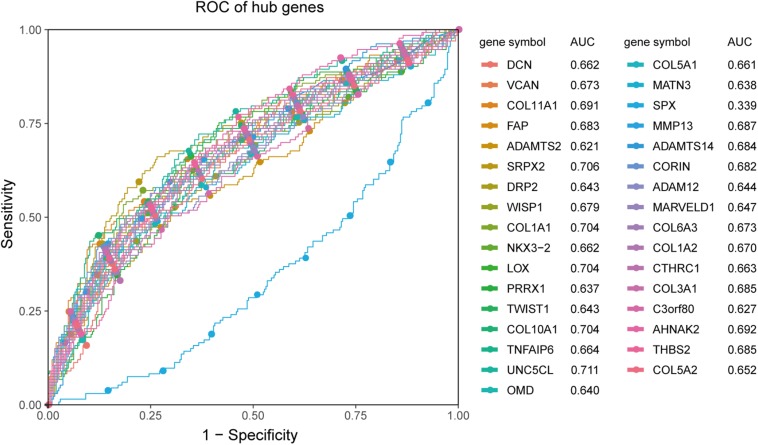
ROC analysis and AUC calculations for hub genes in the TCGA438 dataset. Genes with AUC values <0.5 were considered downregulated. The greater the value of |AUC-0.5|, the more meaningful the hub gene is for ETE diagnosis.